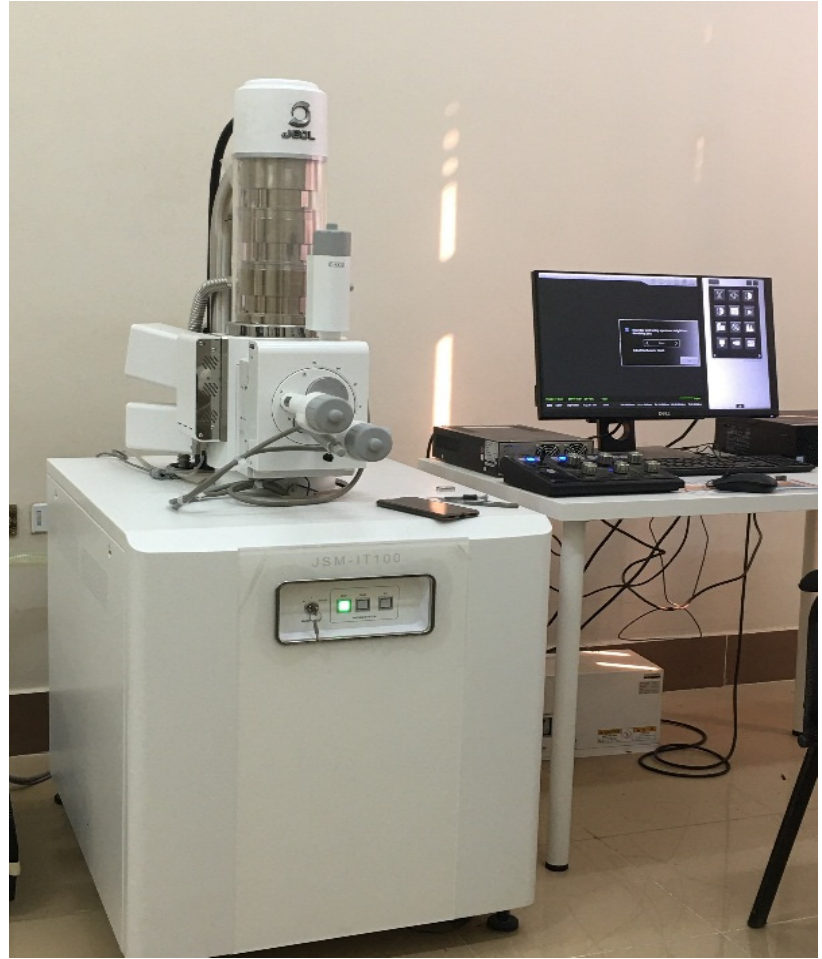
Figure 8. SEM/EDEX Equipment. Table 4. The EDX results of aged bitumen and rejuvenated bitumen. Sample Source Formula